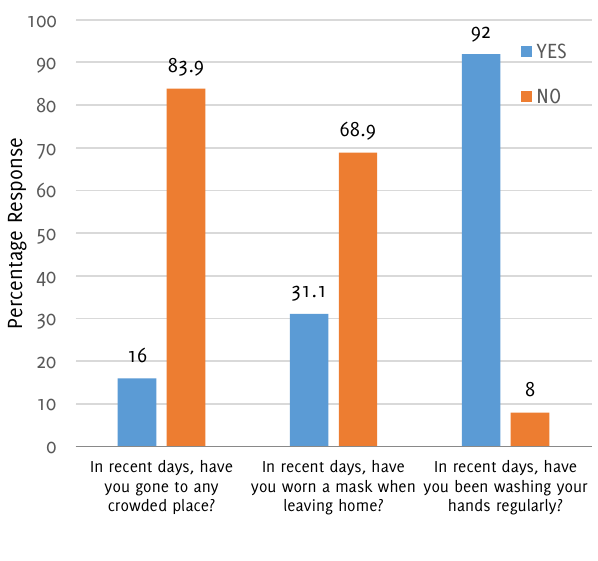
that of Nwagbara et al., a trend that is consistent in many indigenous African studies. This trend is predominant in many African studies contrary to findings in other continents.